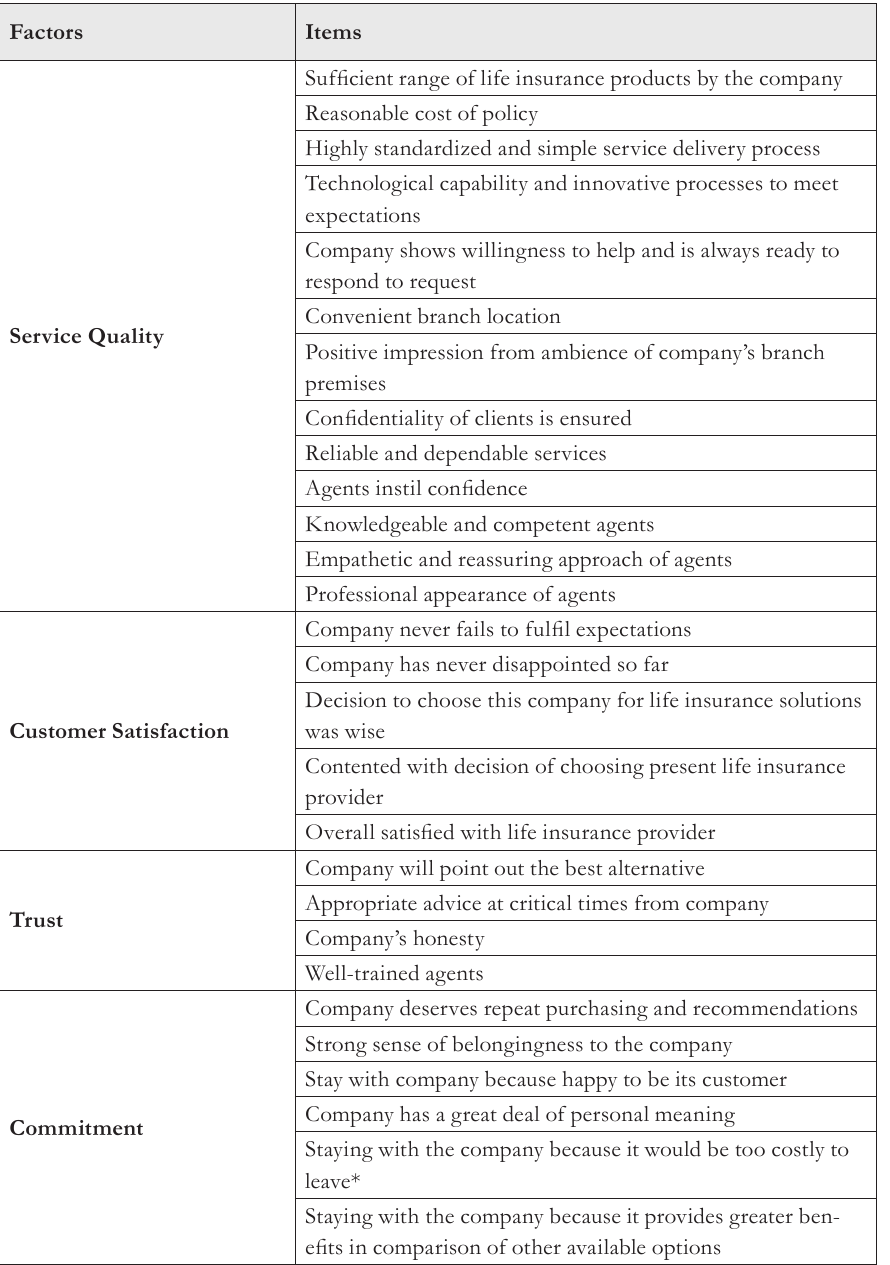
Tab. 1 - Factor wise Items for Assessment of Customer Loyalty. Source: own elaboration. Factors